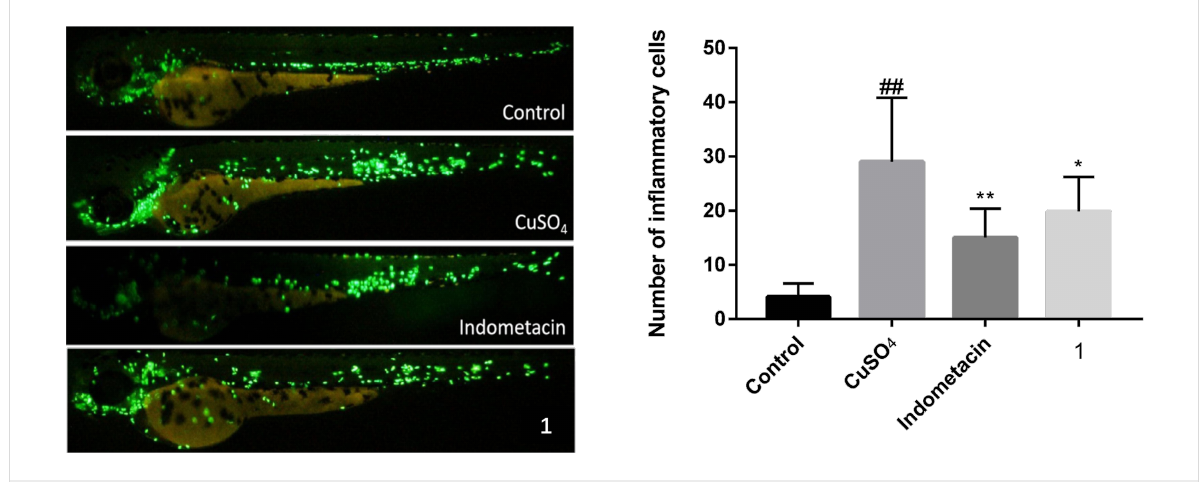
Figure 5: Effects of compound 1 on the anti-inflammation of zebrafish internodes. ## Indicates that the CuSO 4 model group has a very significant difference compared with the blank group ( p < 0.01). * and ** indicate that sample groups have significant differences compared with the CuSO 4 model